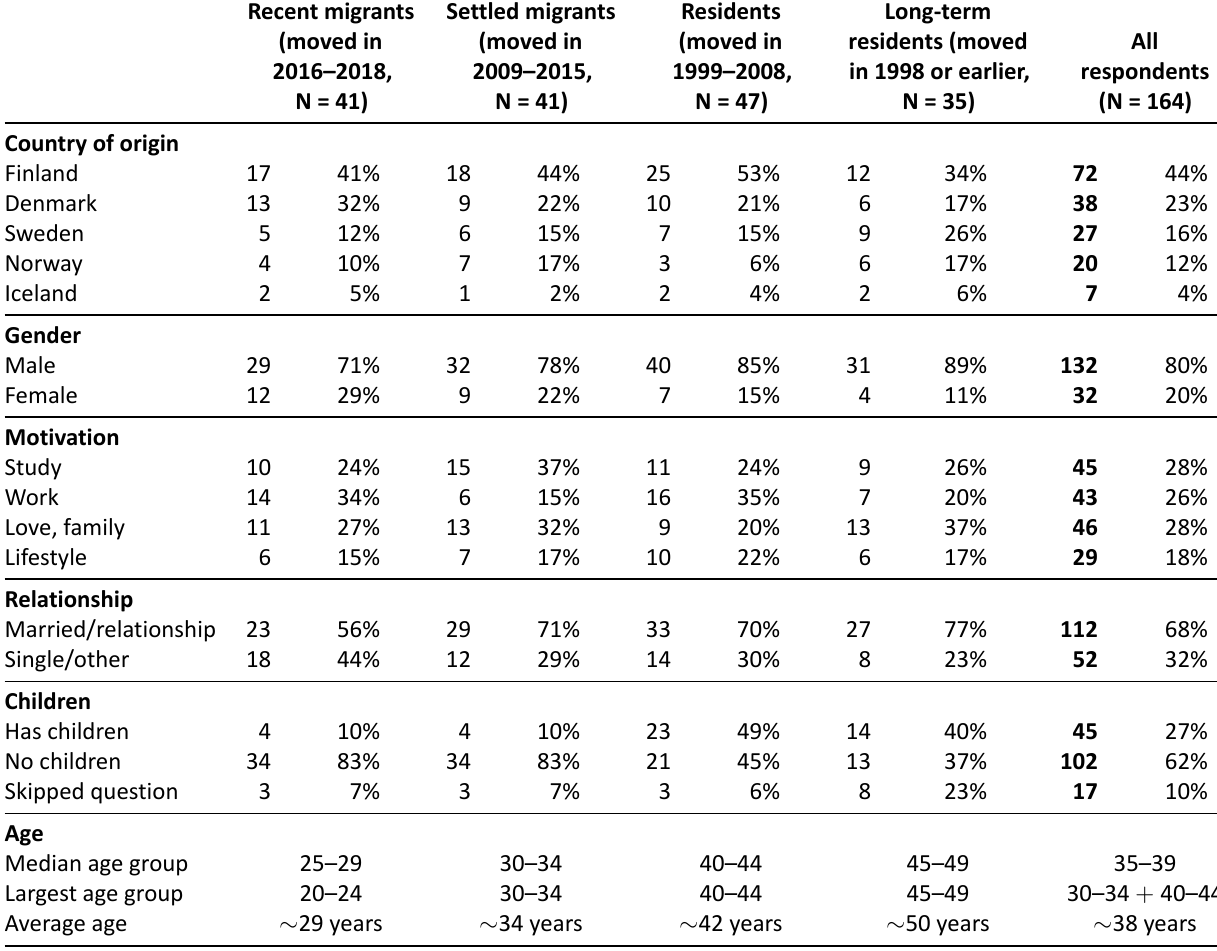
Table 1. Key characteristics of the four migrant